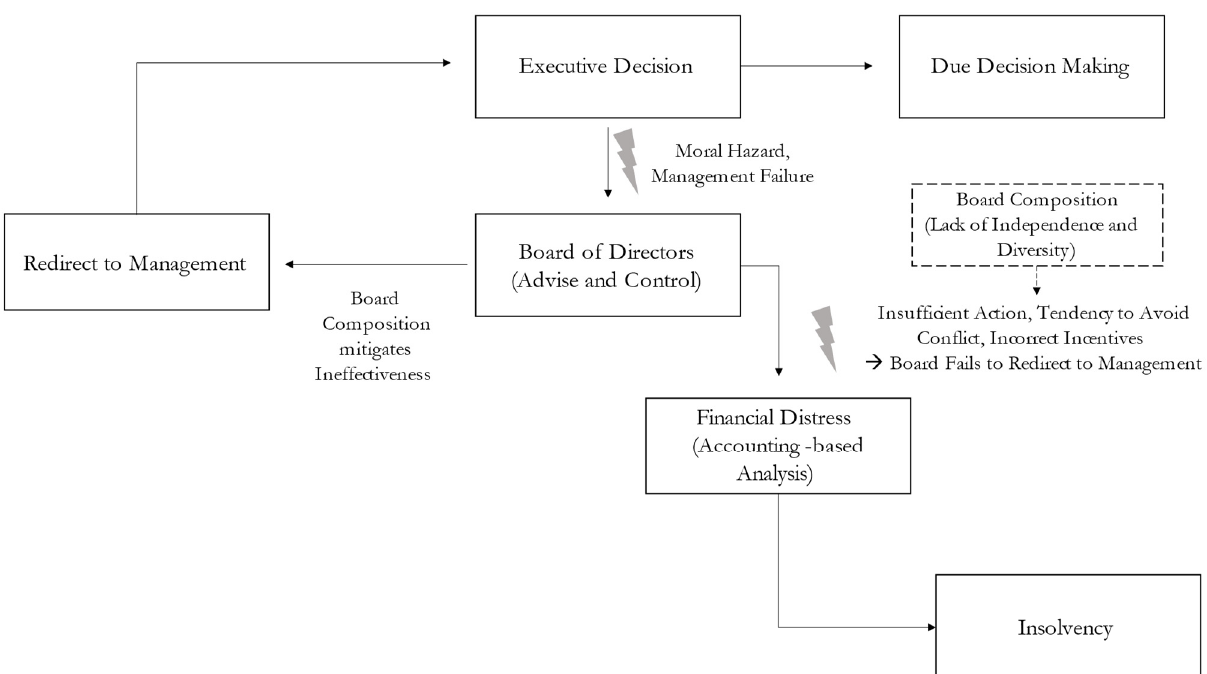
Figure 1. Board Characteristics and Insolvency: Figure summarizes the theoretical considerations to the question of whether board independence and board diversity influence a board’s ability to prevent management failure and thereby mitigate insolvency risk.